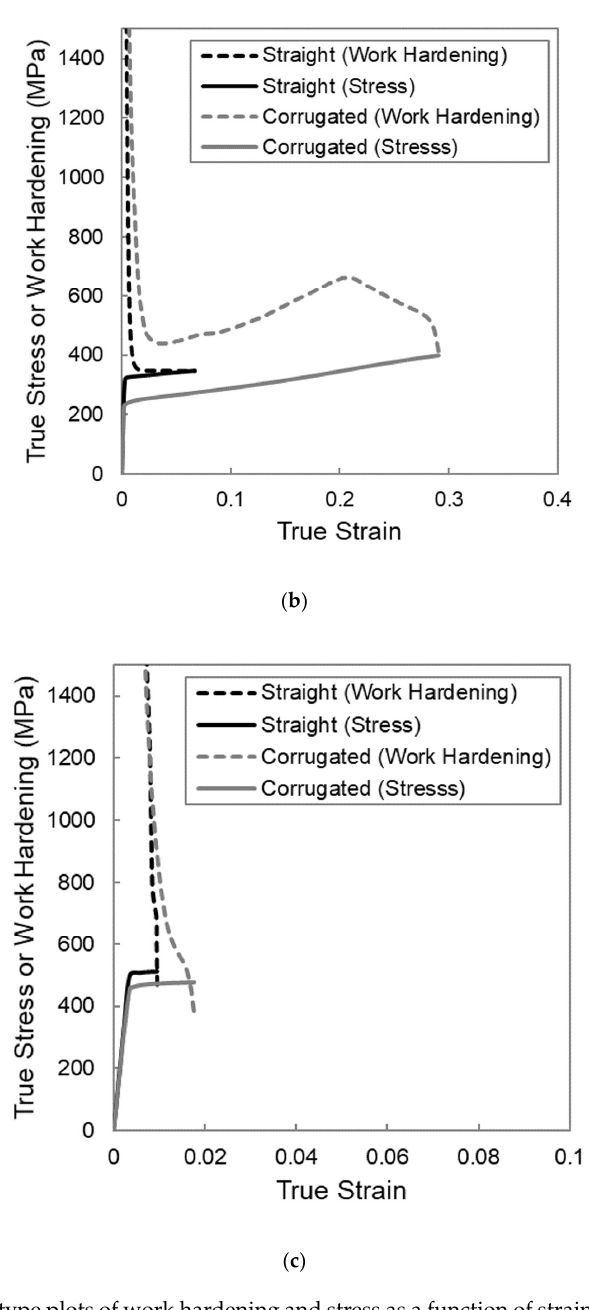
Figure 4. Considere-type plots of work hardening and stress as a function of strain for FEM simulations of straight and corrugation-reinforced composites made from linear hardening materials with different matrix yield strengths, YS(m); ( a ) YS(m) = 50 MPa, ( b ) YS(m) = 200 MPa, ( c ) YS(m) = 400